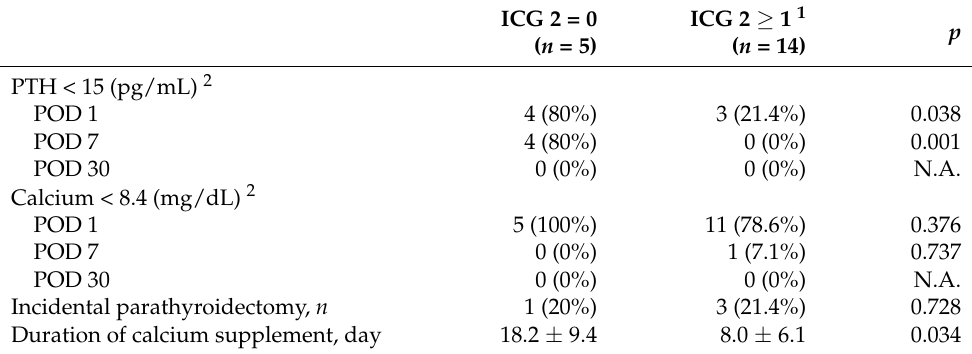
Table 4. Comparison between total thyroidectomy patients with at least one well-perfused parathy- roid gland (ICG 2 ≥ 1) versus no well-perfused parathyroid gland (ICG 2 =